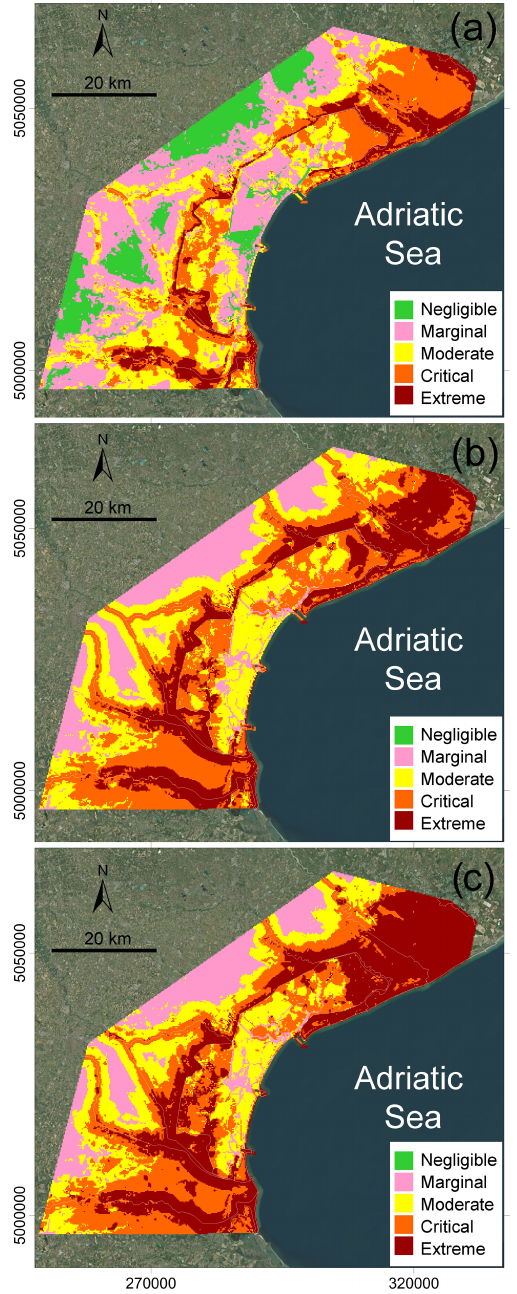
Figure 4. Vulnerability to RSLR of the Venice coastal area: (a) on- going long-time series scenario; (b) ongoing short-time series sce- nario; (c) future scenario in 2050. Base map source: Esri, Digital- Globe, GeoEye, Earthstar Geographics, CNES/Airbus DS, USDA, USGS, Aerogrid, IGN, and the GIS User